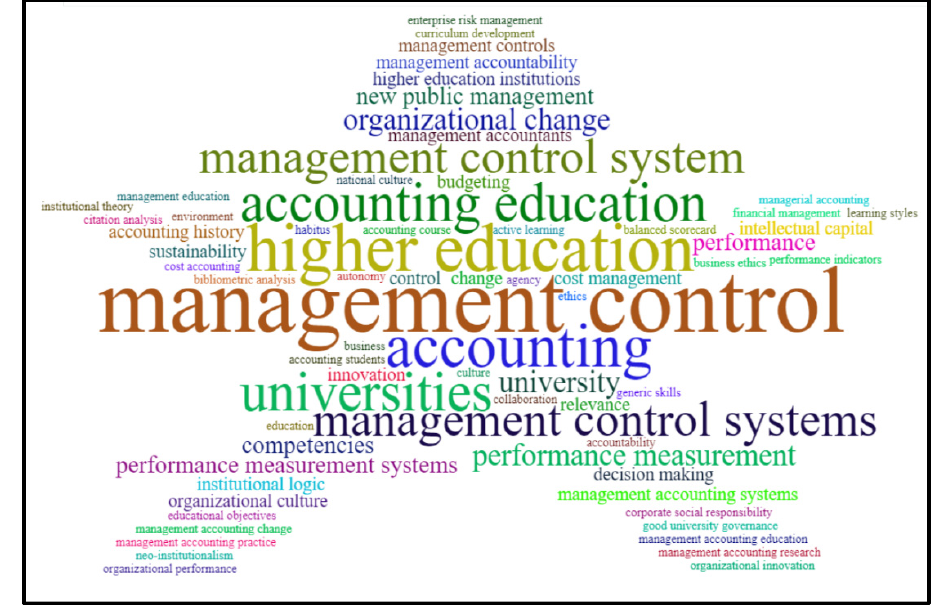
Figure 6. Thematic evolution.